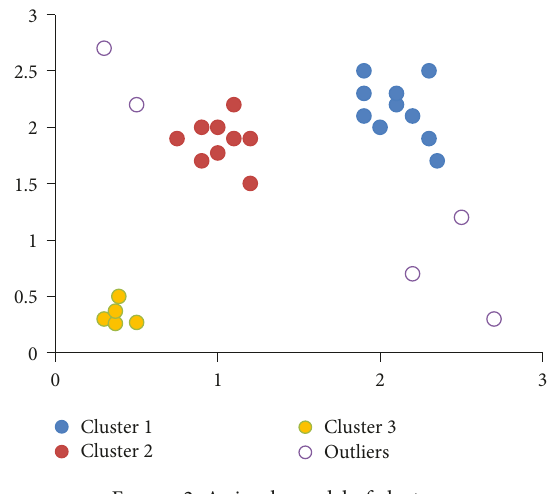
Figure 2: A simple model of clusters.